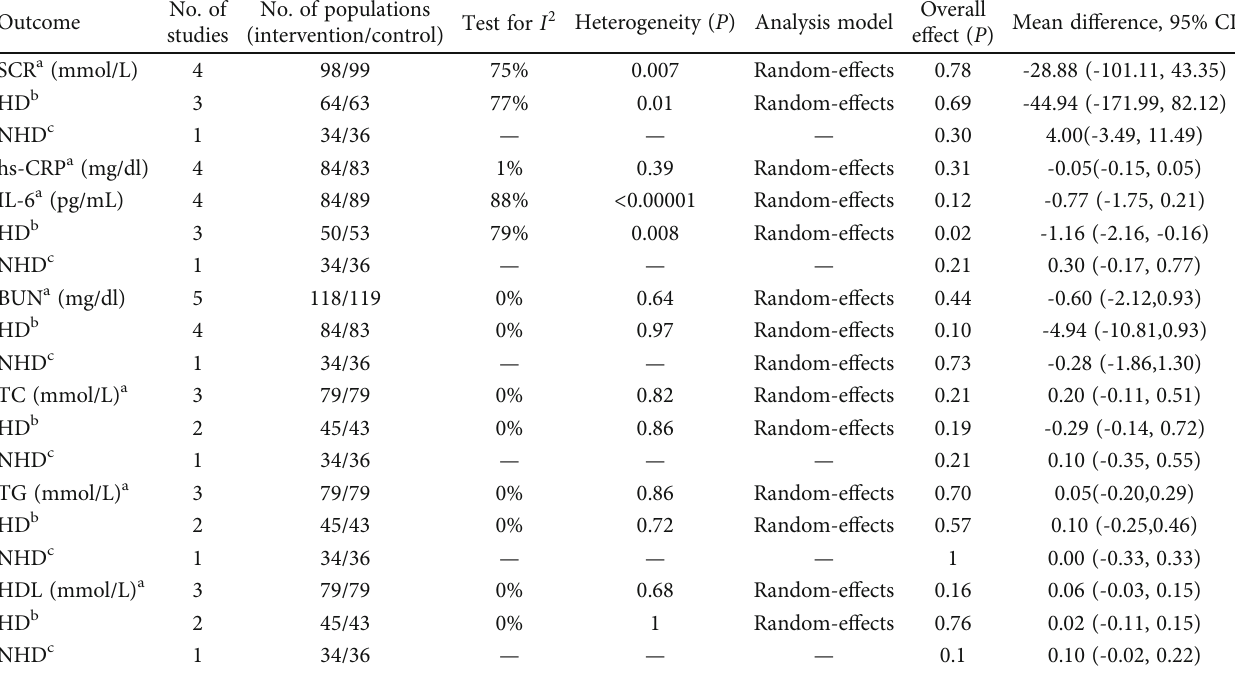
(Table 2). Using the random-e ff ects model, 3 trials were insu ffi cient to detect publication bias.